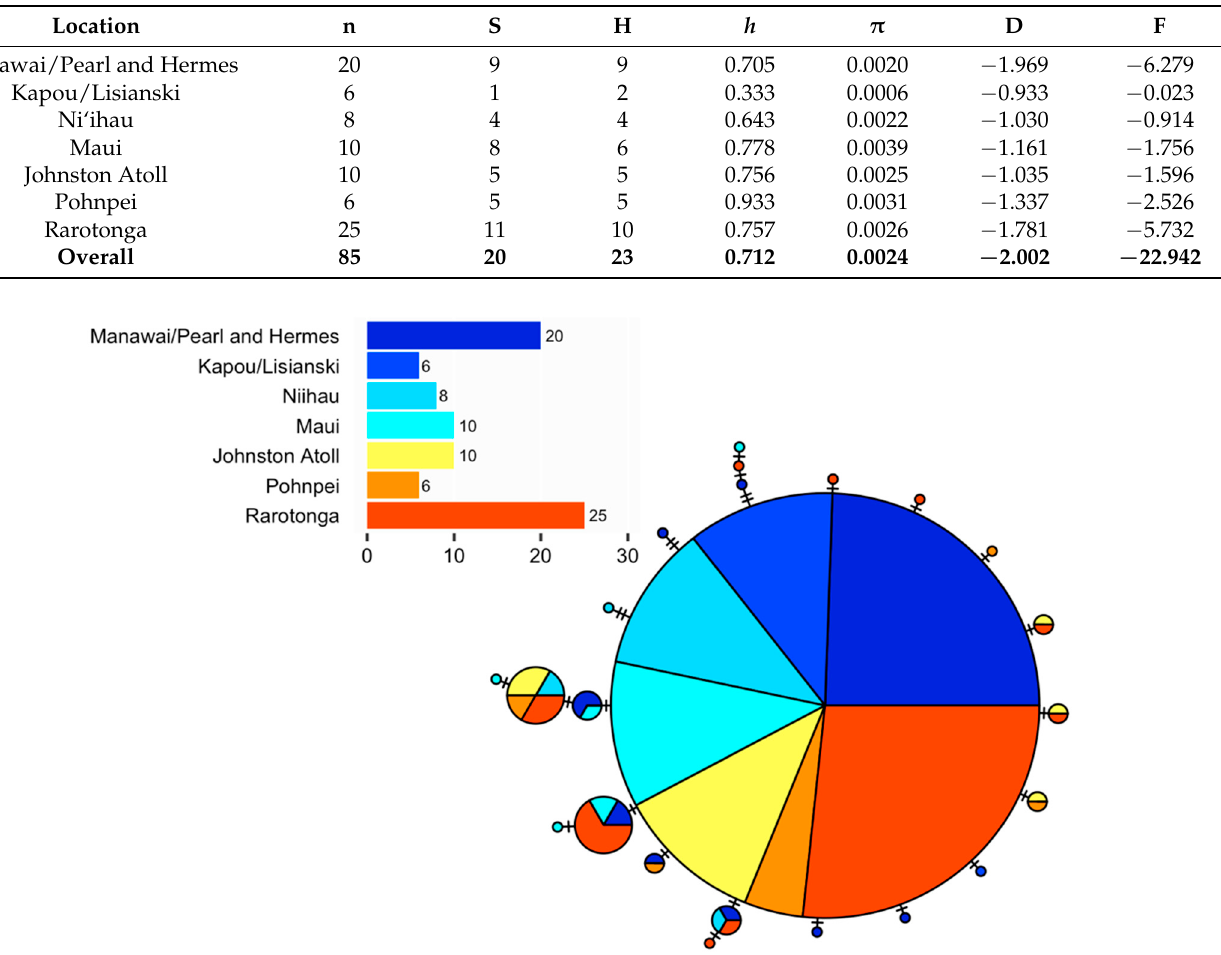
Figure 2. Myripristis chryseres haplotype network. Circle sizes correspond to the frequency of each sampled haplotype. Cool colors represent samples from locations in the Hawaiian Archipelago, while warm colors represent samples from locations across the wider Indo-Pacific. Sample sizes indicated by bar graph.